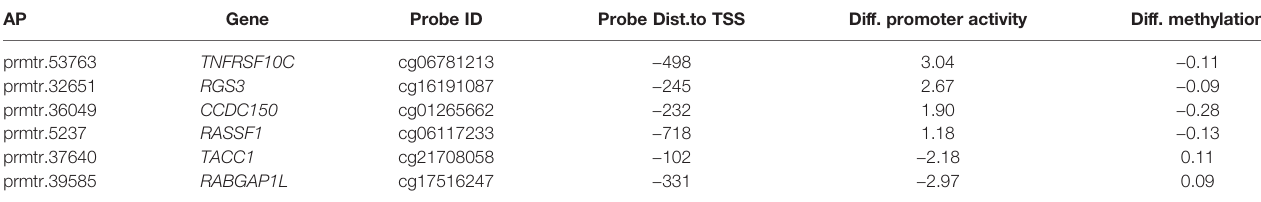
TABLE 1 | Promoter activity and methylation alterations of mrAPs in the HCC diagnosis